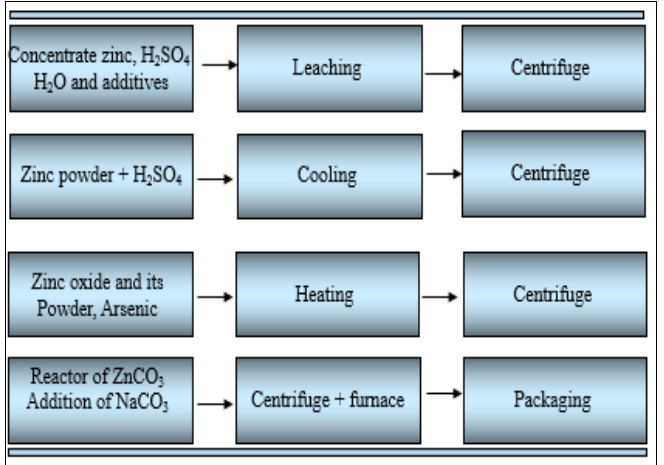
Figure 6: The layout of ZnO generation